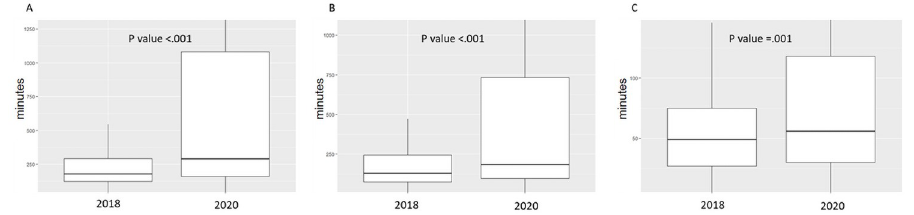
Fig 3. Distribution of total ischemic time and its individual components in STEMI patients before and during the Covid-19 pandemic. The graph represents median and interquartile range of time components from symptom onset to reperfusion therapy during the first wave of Covid-19 (2020) vs the control period (2018). A. Total ischemic time– time from symptom onset to reperfusion. B. Time from symptom onset to hospital admission. C. Time from hospital admission to reperfusion.